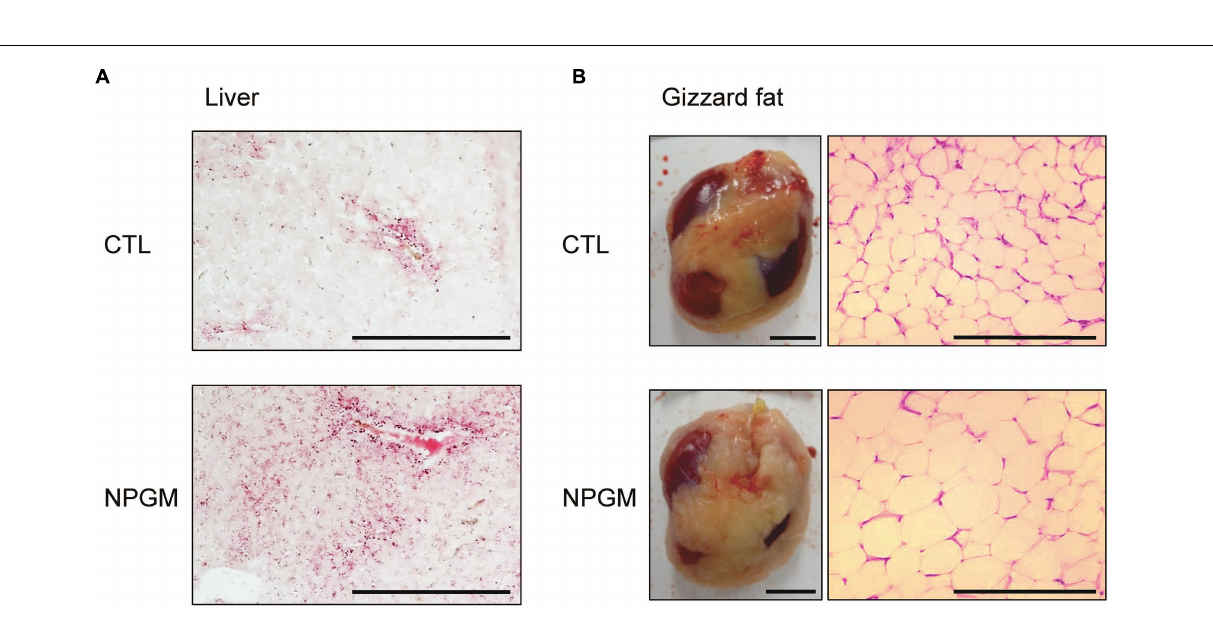
Frontiers in Physiology |